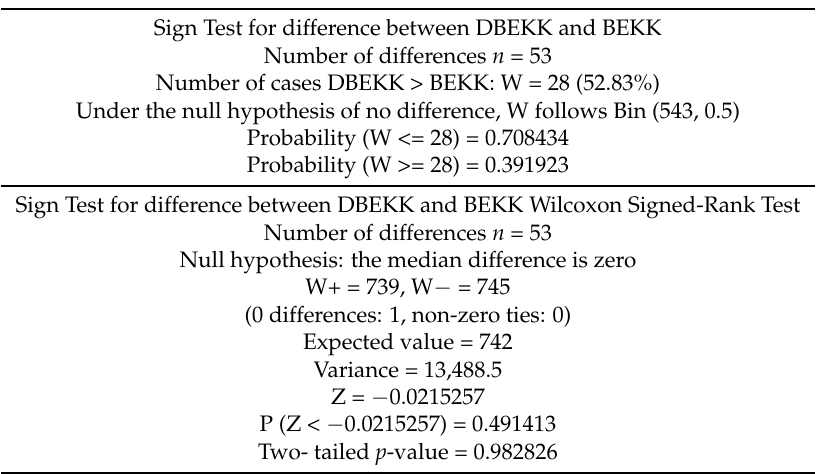
Table 7. Sign Tests of the differences in estimates produced by DBEKK and FULL BEKK: significant coefficients. Sign Test for difference between DBEKK and BEKK Number of differences n = 48 Number of cases DBEKK > BEKK: W = 26 (54.17%) Under the null hypothesis of no difference, W follows Bin (48,